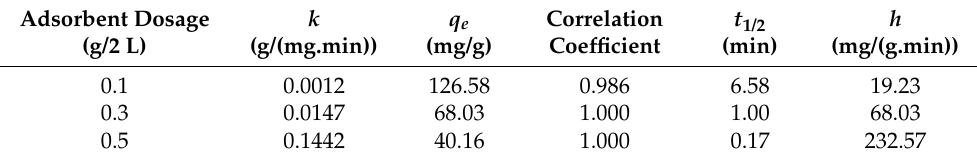
Table 2. Pseudo-second-order model parameters for MB adsorption onto WCH-AC at